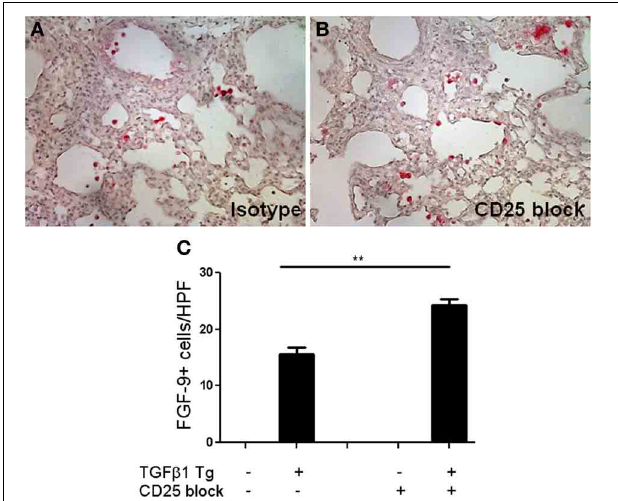
FIGURE 5 | Treg depletion results in increased accumulation of FGF-9 expressing cells in the fibrotic mouse lung. (A,B) Immunohistochemisty for FGF-9 (red) on TGF- β 1 Tg + mice given doxycycline for 14 days and treated with isotype control or anti-CD25 antibody. Tissue sections